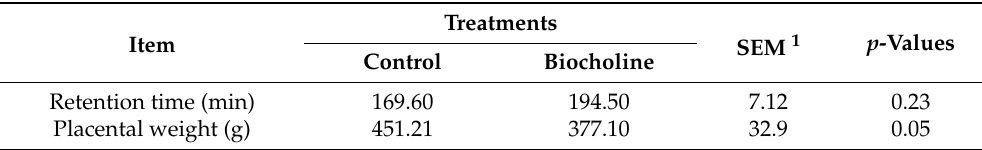
Table 3. Placental weight and time of placental membrane expulsion during lambing from ewes supplemented using an herbal mix as a source of choline during early gestation.